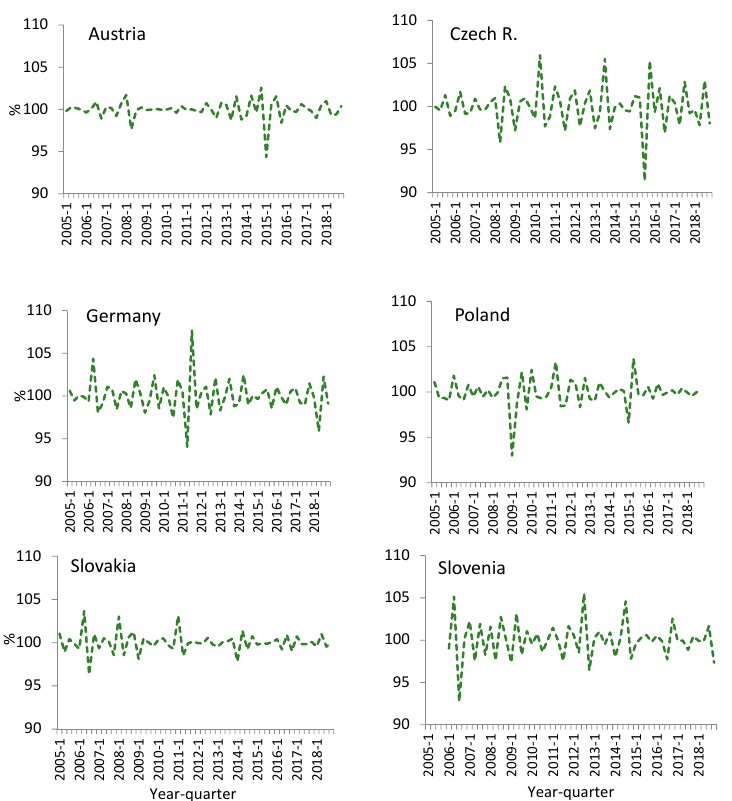
Figure 6. Seasonal fluctuations of beech roundwood prices in selected European countries in 2005– 2018.